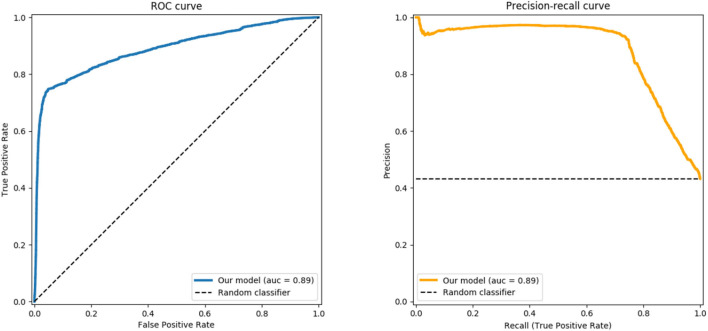
ROC curve (left) and Precision-Recall curve (right) generated using our trained model as a classifier of the interaction sessions for the UE-HRI dataset.